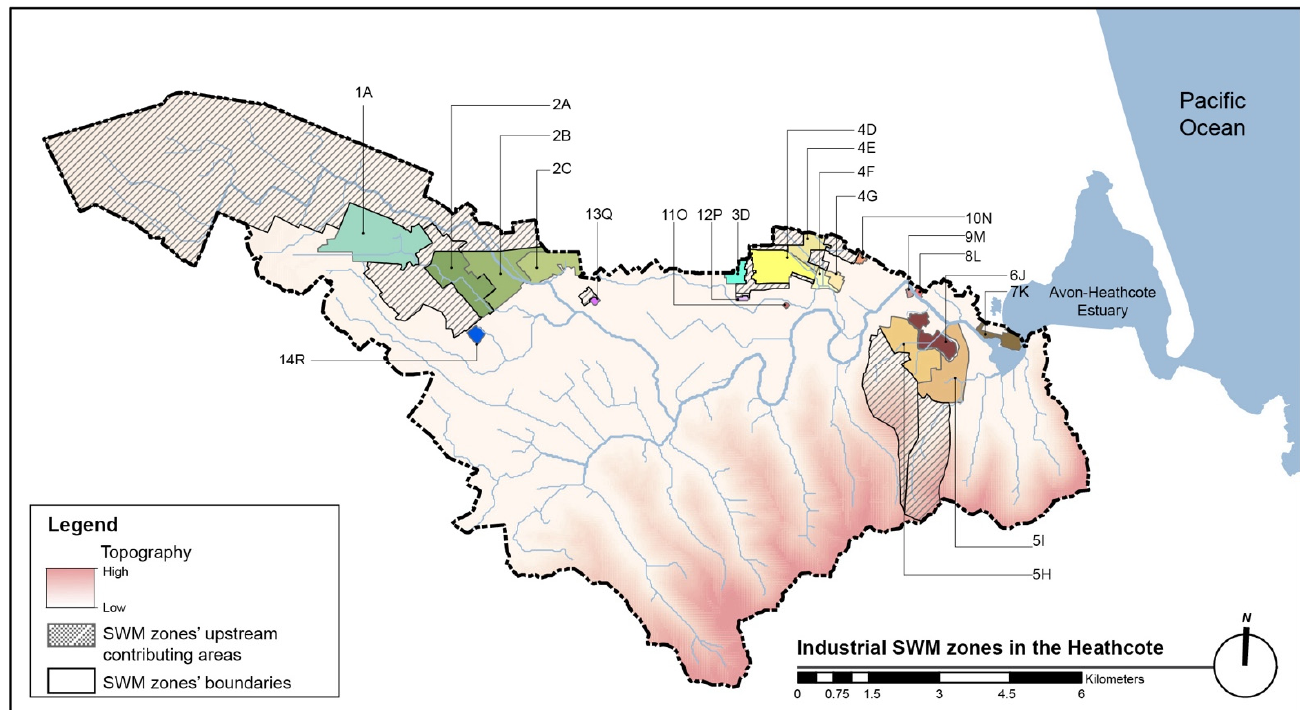
Figure 4. SWM zones in the Heathcote River catchment defined by drainage area boundaries.